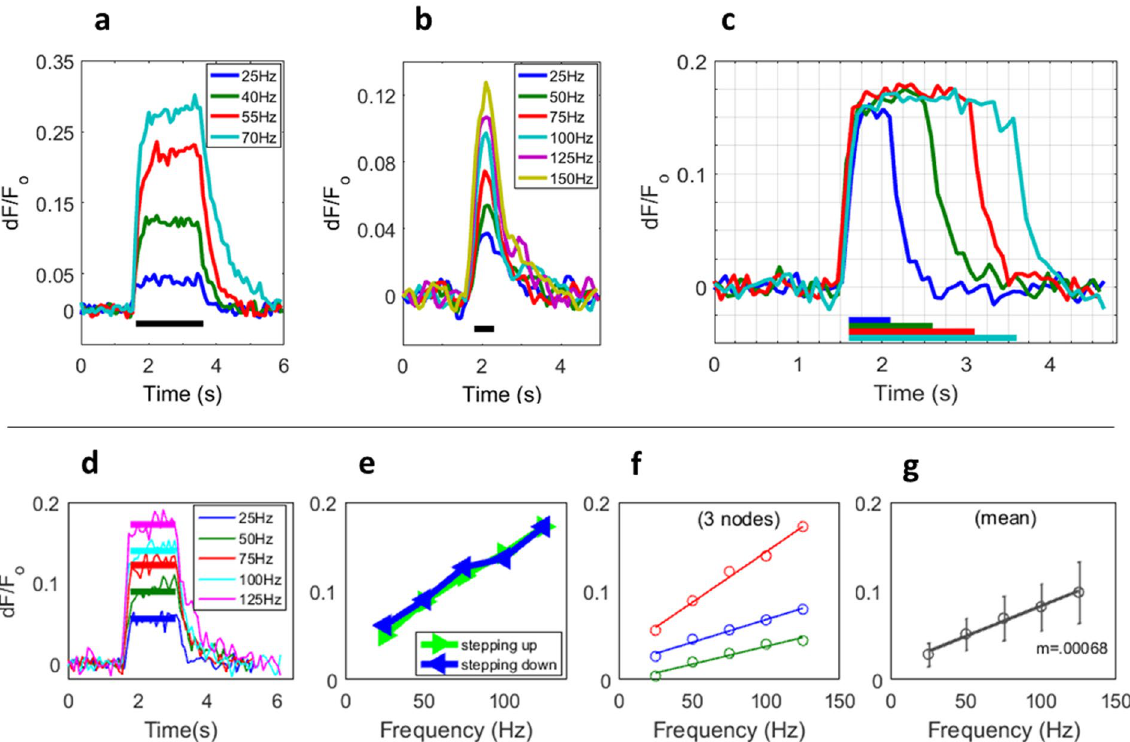
Figure 3. Activity-dependent calcium signal amplitude is modulated by action potential frequency and train duration. ( a ) Calcium signals in response to a 2 s stimulus, and ( b ) to a 0.5 s stimulus at a range of action potential frequencies ( c ) Calcium-fluorescence signals modulated by action potential train duration. Constant frequency (125 Hz) action potential trains are applied at 0.5, 1, 1.5 and 2 s (colored bars, bottom) and the calcium response duration closely follows the stimulus while preserving steady amplitude. The average decay constant for the four signals is 205 ± 15 ms ( d ) Frequency-modulated calcium fluorescence traces with bars indicating mean steady-state amplitude. ( e ) Stimuli/recordings were performed while stepping action potential frequency up and down showing no significant hysteresis effect. ( f ) Signal amplitude versus frequency of nodes from three independent nerve samples as recorded in panel d, and their mean ( g ) illustrates linear dependence with a slope of 0.07% fluorescence/Hz. Data shown are from single sweep recordings with the exception of panel f in which each trace is the mean of the up and down sweeps, and panel g which contains the sample